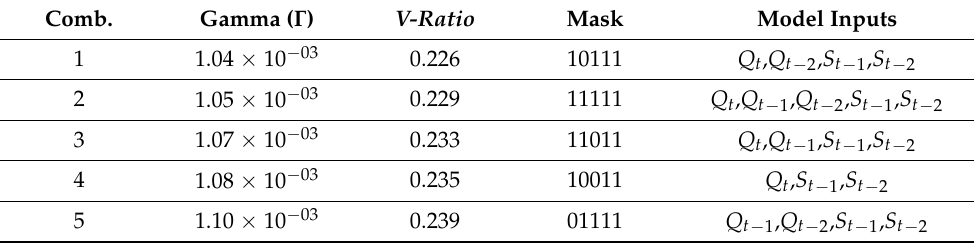
Table 4. Best input and output combinations based on GT for the Magdeburg-Strombrücke gauging station.